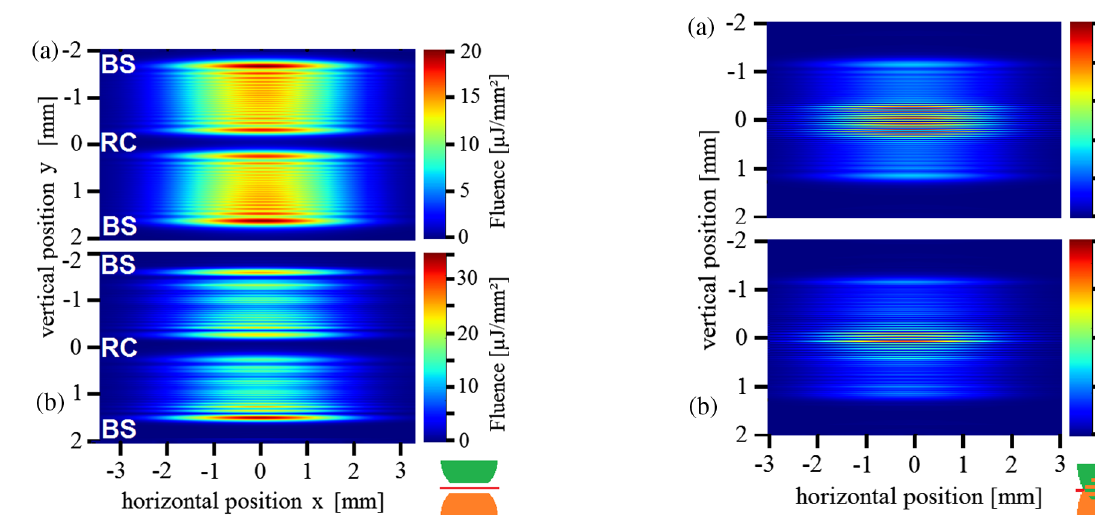
FIG. 6. Both half beams overlapping each other by Δ y d ¼ 0 . 75 mm for ideal flat mirrors (a) and for mirrors with Δ h ¼ 4 . 7 nm within the footprint of the beam